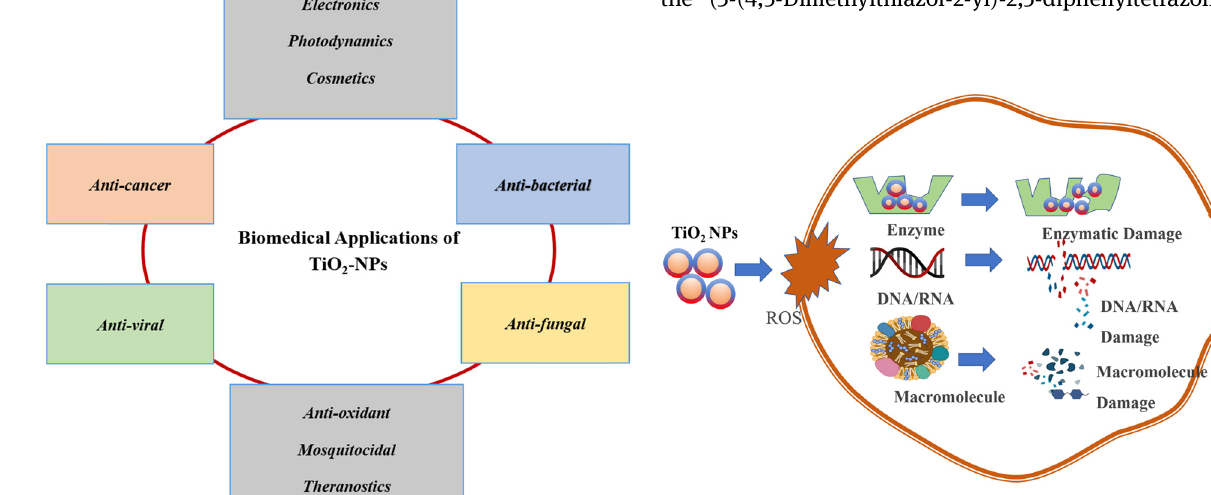
Figure 5: Schematic sketch of the TiO 2 - NP e ff ect on the bacterial